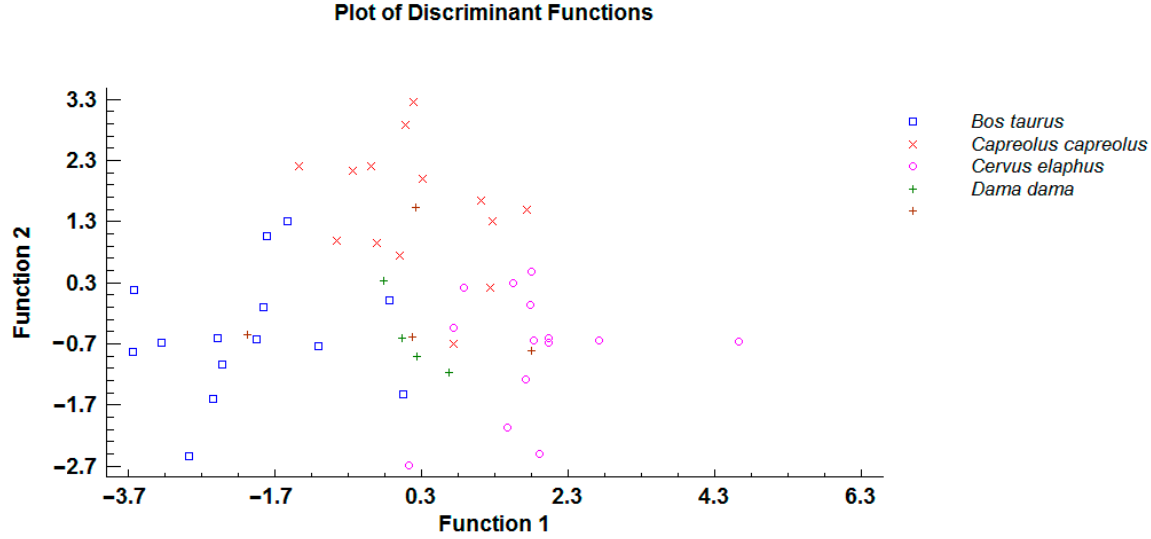
Figure 4. Scatter plot of discriminant function analysis comparing selected morphological characteristics of Ostertagia leptospicularis males derived from different host species (brown crosses indicates particular